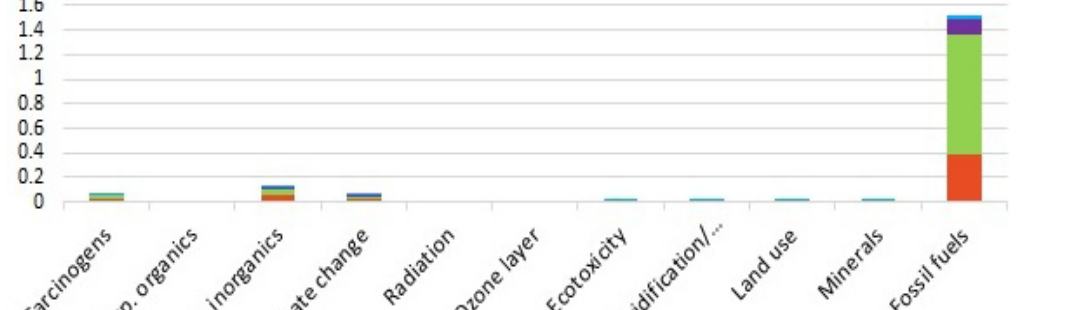
Taghizadeh Isini L, et al. Life Cycle Assessment of Formalin and Hexamine Production Units. J Adv Environ Health Res. 2022;